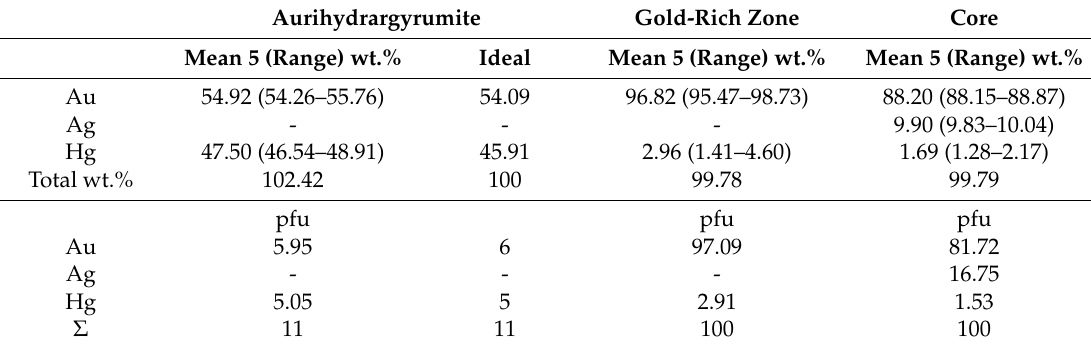
Table 1. Analytical data for aurihydrargyrumite and the inside of the particles. Aurihydrargyrumite Gold-Rich Zone Core Mean 5 (Range)